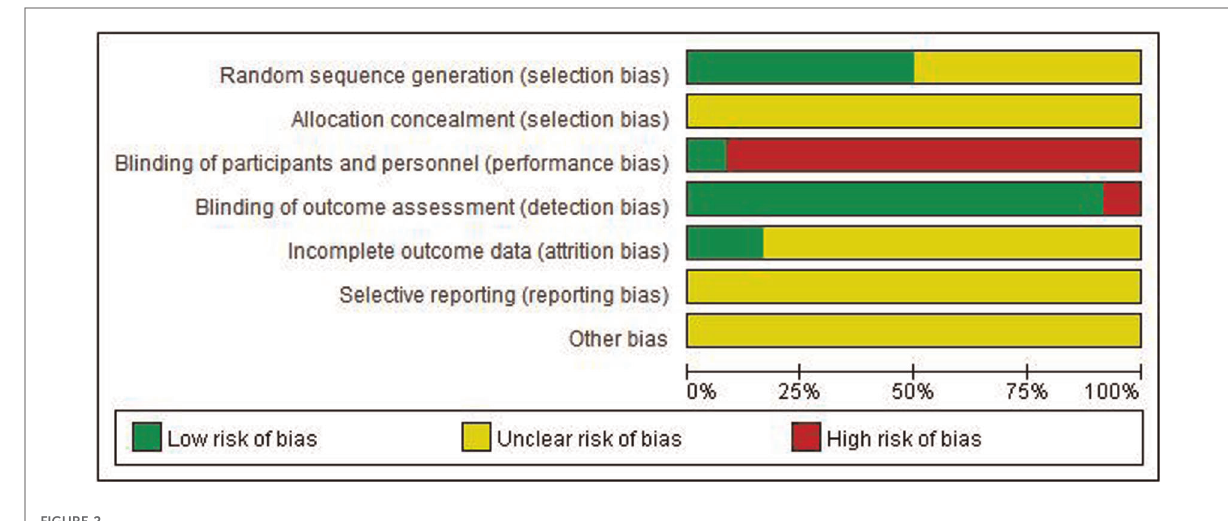
FIGURE 2 Quality assessment of the trials included in this meta-analysis. Risk of bias